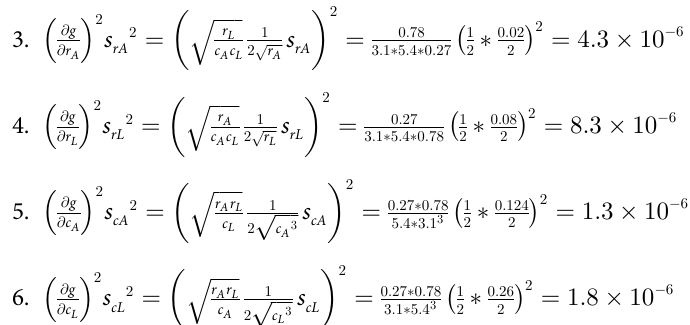
S1 Fig. Using A − L + phenotypes measured in batch monocultures supplemented with ade- nine versus hypoxanthine did not affect model performance. “Exp”: community growth rates were calculated from seven independent experiments in a well-mixed environment (from about 30 h to 70–80 h) and averaged, with the error bar representing 2 standard devia- tions. “Model ii”: all model parameters were derived from L − A + and A − L + of the RM11 genetic background measured in batch monocultures. We predicted steady-state community growth rate either via quantifying the simulated post-lag dynamics (e.g., Fig 1B “Model ii”) (“Sim”) or via an analytical formula (Eq 17 in Methods) (“Cal”). The experimental and predicted dou- bling times were 6.5 and 4.3 h, respectively. Experimental data and model parameters are listed in S1 Data and S2 Table, respectively. Cal, calculation; Exp, experiment; Sim, simulation. (TIF) S2 Fig. Prestarving A − L + reduces the lag phase of community growth. Exponential A − L + (WY1340) cells were washed free of hypoxanthine and either prestarved for 24 h in SD (solid lines) or not prestarved (dotted lines) before being mixed with exponentially grown and then washed L − A + (WY1335) to form CoSMO. Prestarvation of A − L + leads to less growth lag com- pared with no prestarvation. All data can be found in S8 Data. CoSMO, Cooperation that is Synthetic and Mutually Obligatory. S3 Fig. Inosine does not mediate the interaction from L − A + to A − L + . ( A ) Hypoxanthine but not inosine is consumed by A − L + . The final turbidity of an ade8− (WY1340) tester strain increases with increasing concentrations of hypoxanthine (blue) and adenine (gray), but not inosine (brown). The slopes of the blue and gray lines are similar, suggesting that a similar amount of hypoxanthine and adenine are consumed to produce one new A − L + cell. ( B ) Stimu- lation of the A − L + (WY1340) growth rate by hypoxanthine (blue) is not affected by the pres- ence of inosine at 1 × (orange) or 10 × (brown) concentration. All data can be found in S9 Data. S4 Fig. Hypoxanthine and adenine lead to quantitatively different growth phenotypes in A − L + . A − L + cells grow faster when fed with adenine (red) than when fed with